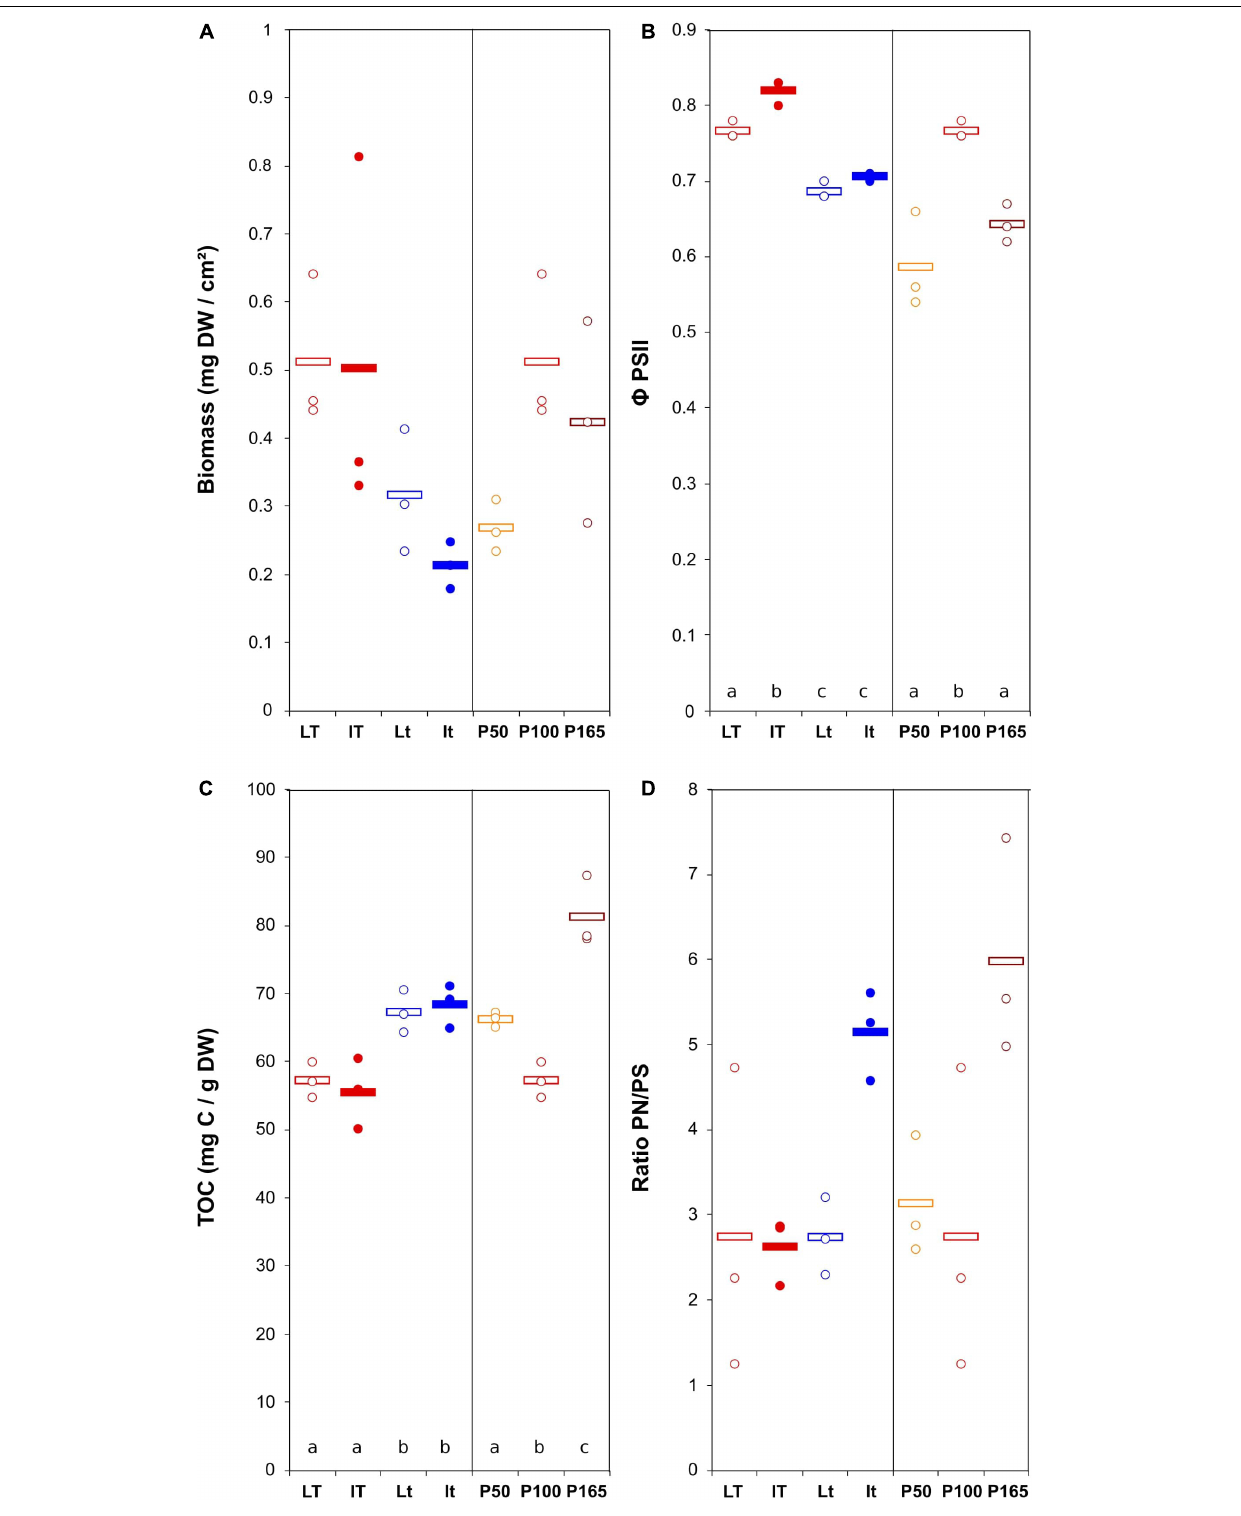
Frontiers in Microbiology |